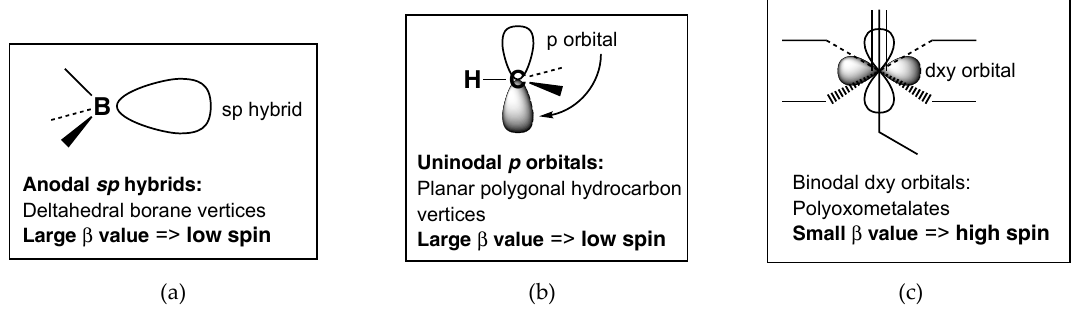
Figure 1. The relationship between the atomic orbitals involved in aromatic and other delocalized systems and the relative values of the interaction parameter β . ( a ) Deltahedral borane systems; ( b ) Planar polygonal hydrocarbon systems; ( c ) Polyoxometallate systems including vanadoborates.